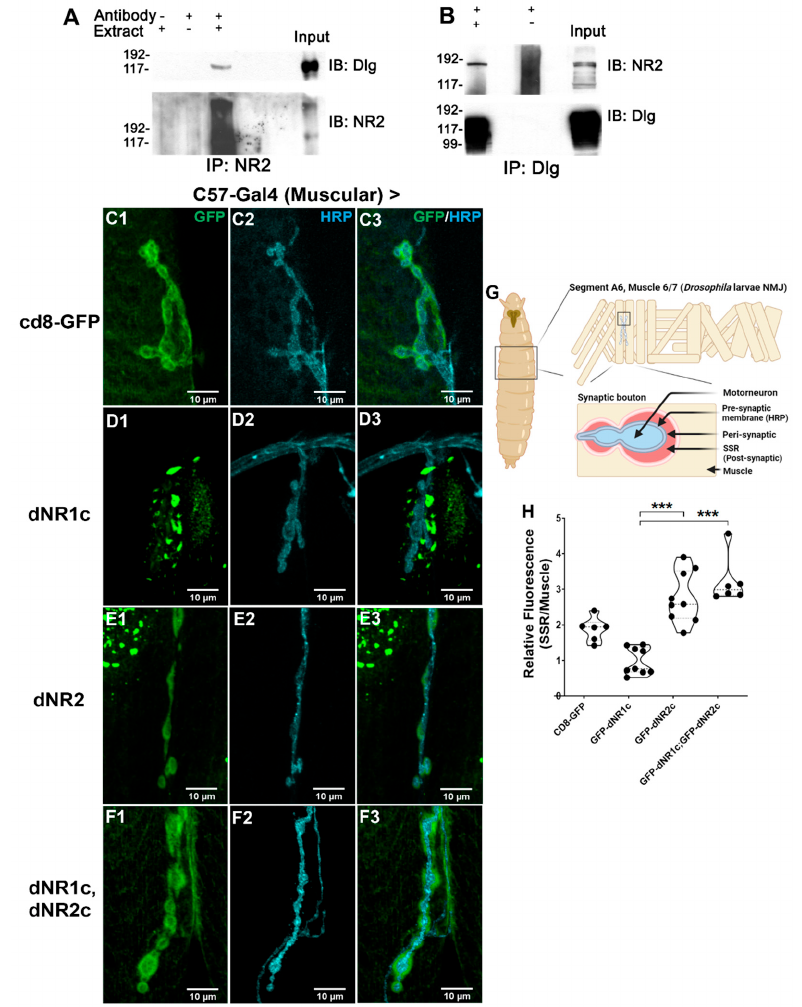
Figure 3. Dlg interacts with Glutamatergic NMDA Receptors. ( A , B ) Immunoprecipitation experi- ments used antibodies against NR2 subunit ( A ) or Dlg ( B ) to precipitate the complex, in turn, NR2 ( B ) and Dlg ( A ) antibodies were used to determine the interactions; ( C1 – F3 ) Representative images of the distribution of dNR1 (dNR1c) and dNR2 (dNR2c) tails overexpressed in the muscle in control flies detected by immunofluorescence against GFP ( C – F ) to label the constructs CD8– GFP-dNR1 (dNR1c) or CD8-GFP-dNR2 (dNR2c), antibodies against HRP were used to label the presynaptic boutons ( C2 – F2 ); the merged images are in ( C1 – F3 ); ( C1 – C3 ) expression of CD8-GFP as control of the distribution of a membrane protein. ( D1 – D3 ) distribution of NR1 tail; ( E1 – E3 ) distri- bution of NR2 tail; ( F1 – F3 ) distribution of the GFP label when dNR1c and dNR2c are co-expressed;